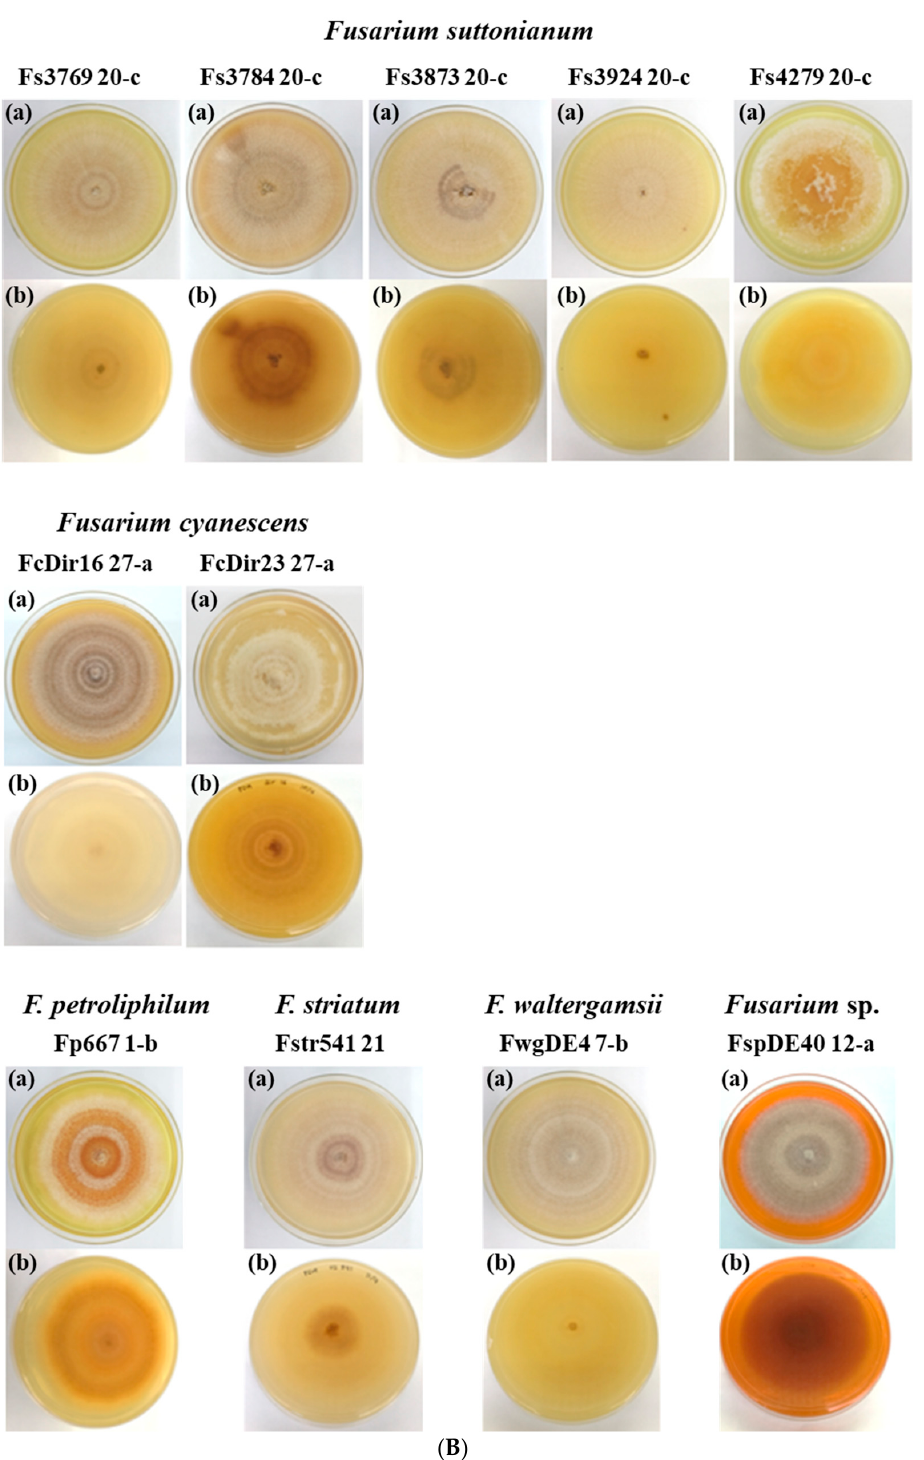
Figure 2. ( A ). Colony morphologies of F. keratoplasticum (ten) and F. falciforme (four) isolates grown on PDA at 28 °C for two weeks with alternating 12 h light and 12 h dark periods. View from the top (a) and underneath (b). ( B ). Colony morphologies of F. suttonianum (five), F. cyanescens . (two), and one each of F. petroliphilum , F. striatum , F. waltergamsii and Fusarium sp. isolates grown on PDA at 28 °C for two weeks with alternating 12 h light and 12 h dark periods. View from the top (a) and underneath (b).